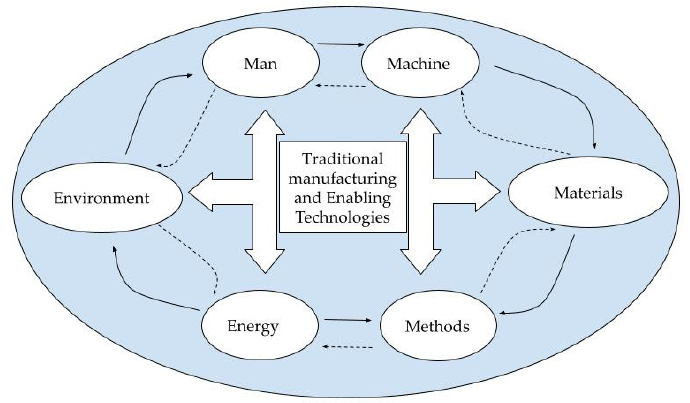
Figure 1. The Convergence model connecting all relevant elements to traditional manufacturing and existing enabling technologies that facilitate smart